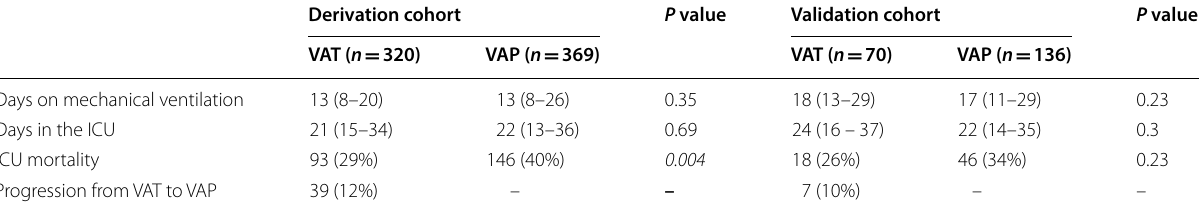
Data are presented as number (%) or median (interquartile range) ICU Intensive Care Unit; VAP Ventilator-Associated Pneumonia; VAT Ventilator-Associated Tracheobronchitis p values < 0.05 are indicated in italics characters